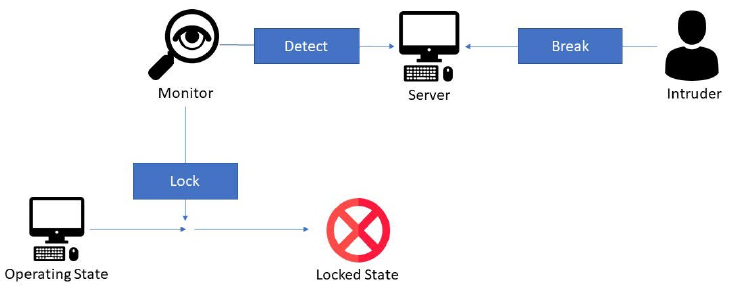
Figure 9. Diagram of the lock function process.